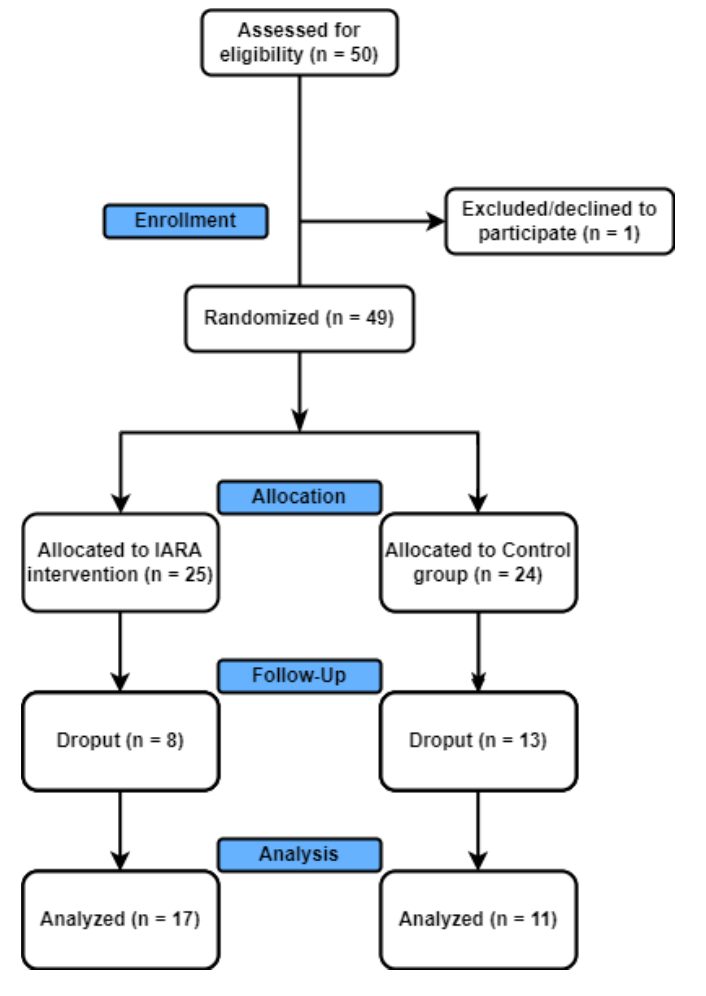
Figure 1. Consort diagram. The final sample, excluding dropouts, was composed of 17 patients for IARA and 11 for Controls.